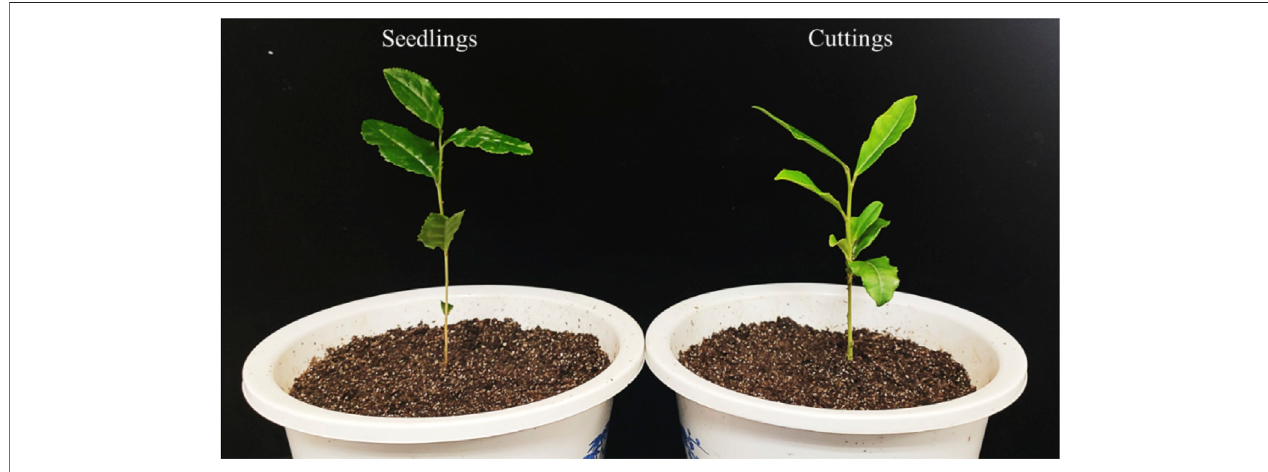
FIGURE 1 | Picture of seedings and cuttings tea